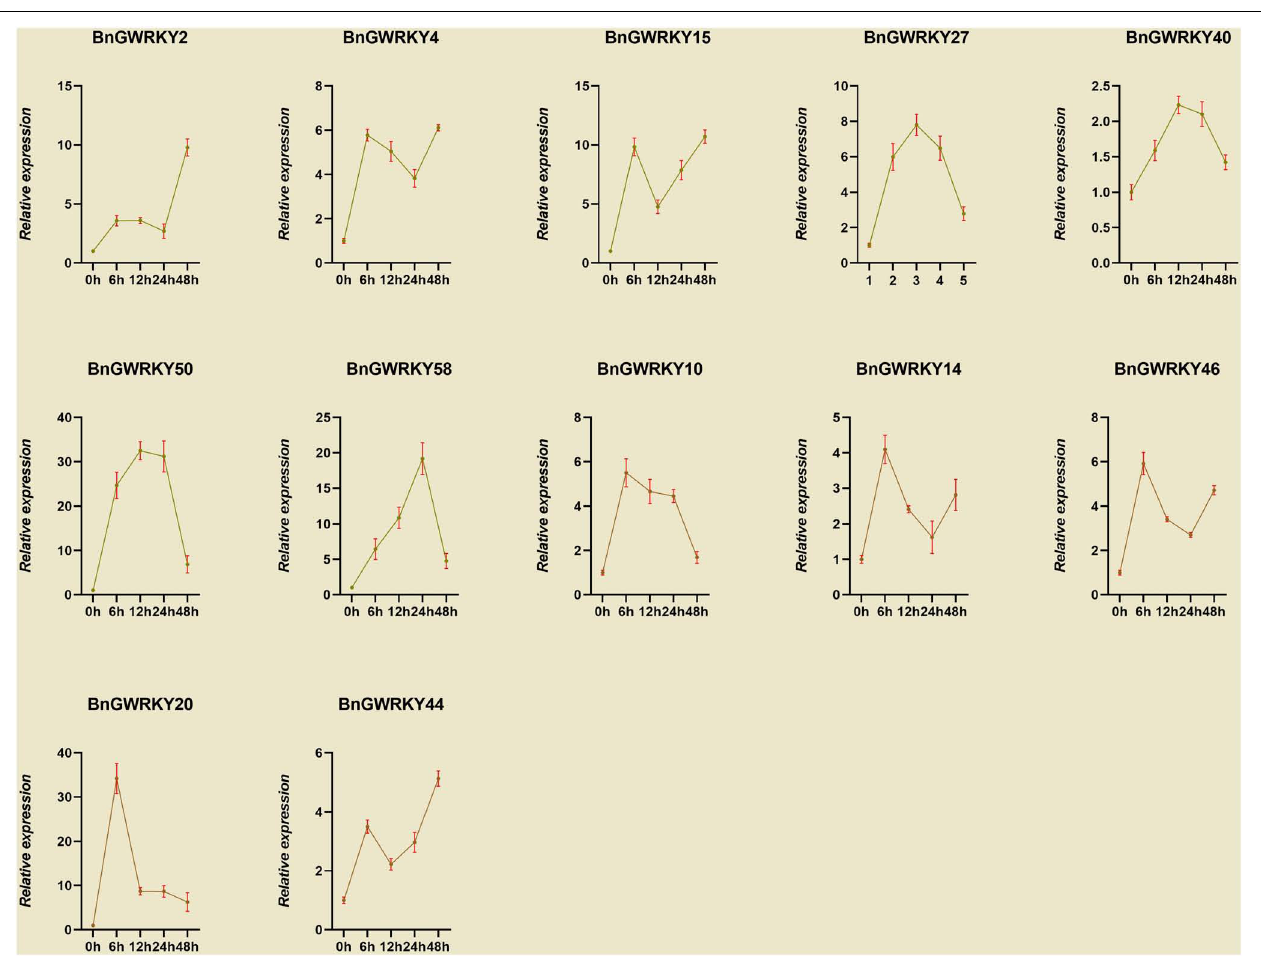
FIGURE 10 | The relative expression levels of selected WRKY genes in ramie leaf at different periods under Cd + 2 treatment (0, 6, 12, 24, and 48 h). The error bar represents the standard deviation of the three biological